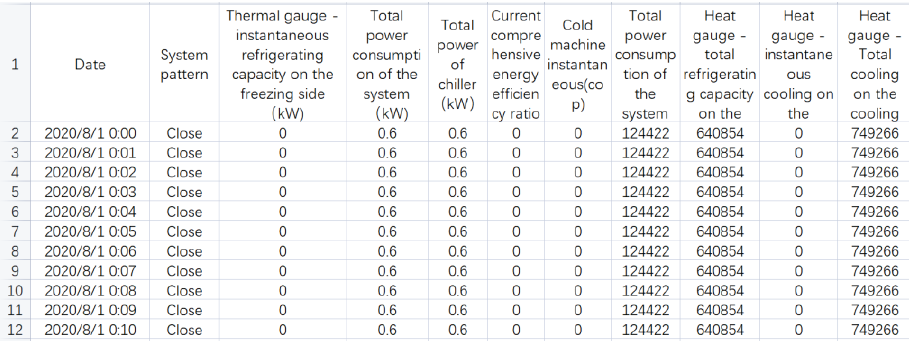
Figure 6. Some of the data collected on 1 August